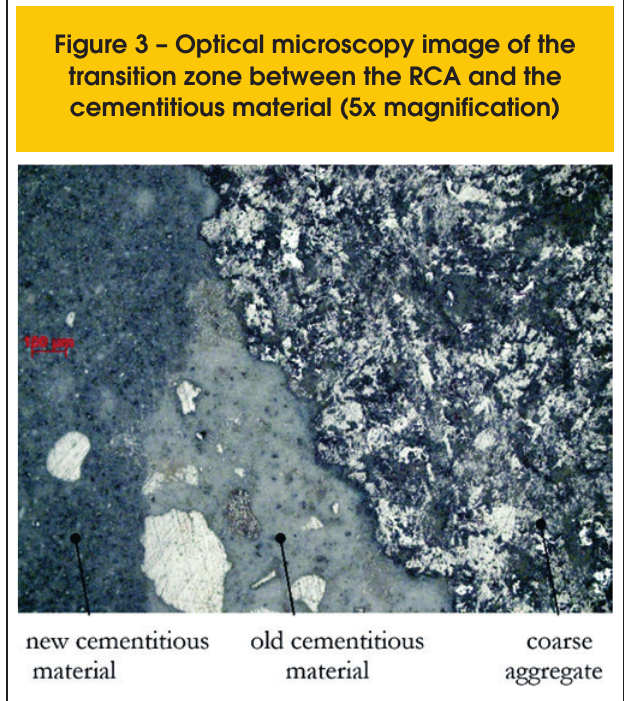
Figure 3 – Optical microscopy image of the transition zone between the RCA and the cementitious material (5x magnification)